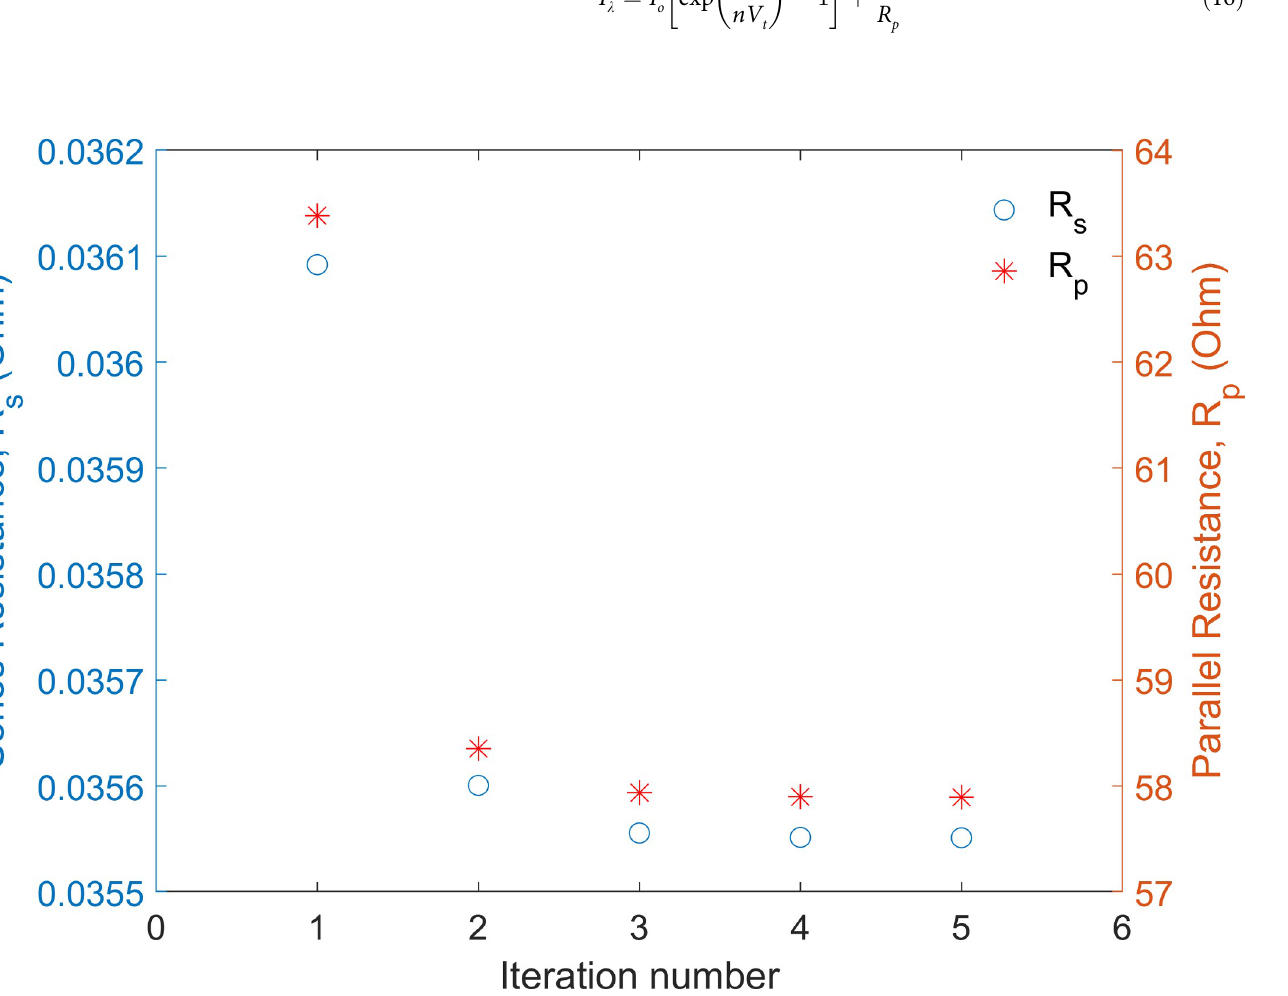
PLOS ONE | https://doi.org/10.1371/journal.pone.0216201 May 2,